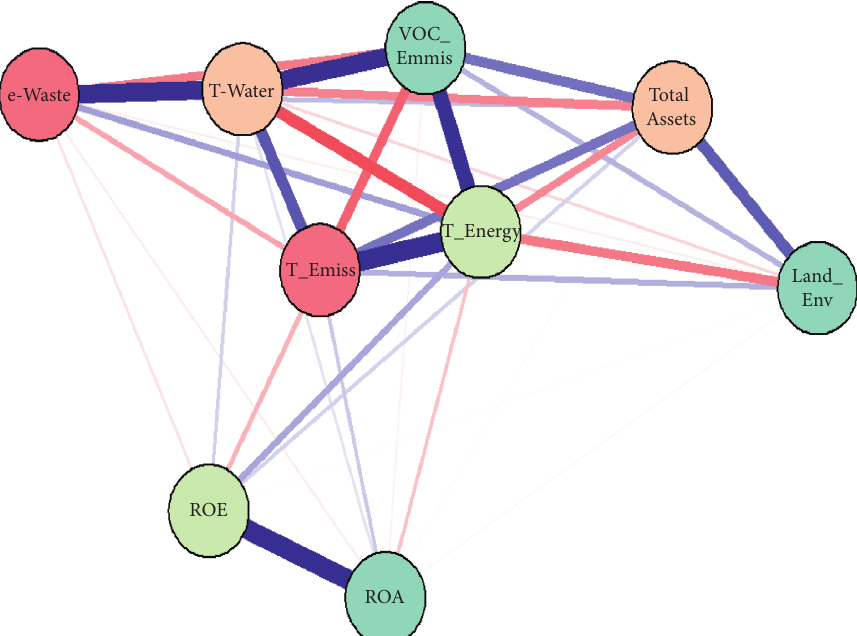
Figure 6: The association between the policy measures and the financial performance (GGM), for the oil and gas companies from the EEA, 2009–2018. Source: own contribution in R